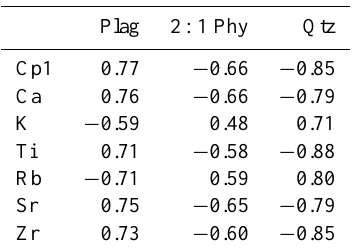
Table 2. Correlation between mineralogy and elemental